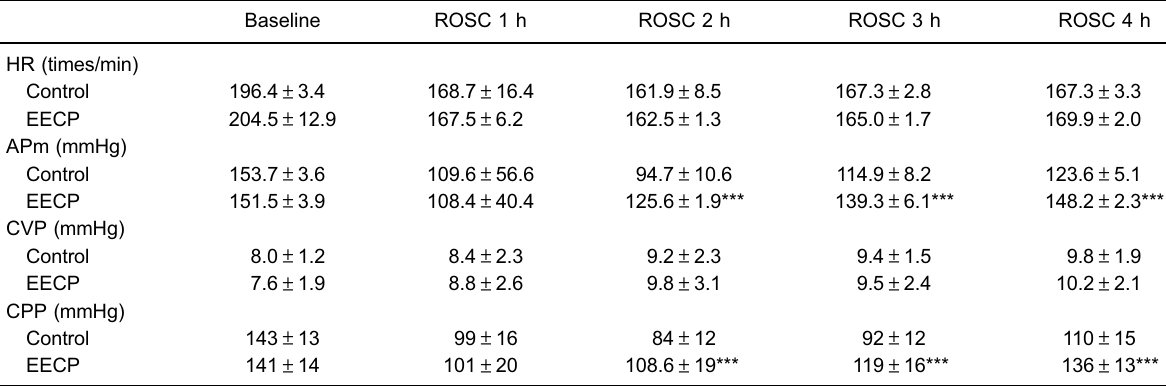
Table 2. Comparison of hemodynamic parameters between Control and enhanced external counterpulsation (EECP) groups after return of spontaneous circulation